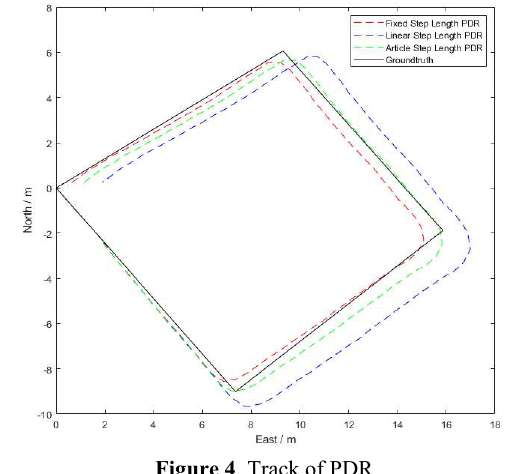
Figure 4 . Track of